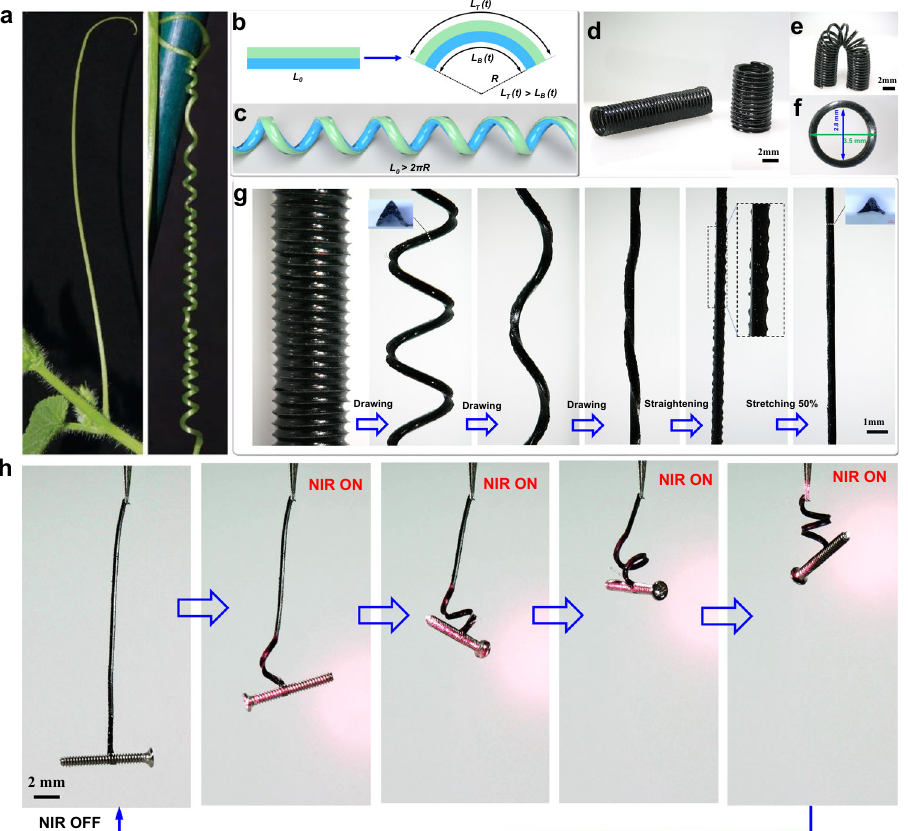
Fig. 1 Bioinspired design of self-winding fi ber actuator. a Photographs showing a straight tendril (left) and a coiled tendril (right). b , c A simpli fi ed physical model describing how the helical coiling of plant tendril is formed. In this model, the tendril is simpli fi ed as a fi lament composed of two layers. Differential growth in the two layers induces intrinsic curvature that leads to spontaneous formation of helices ( c ) to avoid steric interactions when the length of the fi lament is long enough ( L 0 > 2 π R ). L 0 is the initial length and R is the radius of the arc of the curved fi lament. L T ( t ) and L B ( t ) is the length of the top layer and the bottom layer of the curved fi lament after growing for a time t , respectively. d , e Photograph showing the precursor of helical soft springs used for the preparation of the self-winding fi ber actuators. f Photograph showing a coil of the helical soft spring from the top view. The outer and inner diameter of the coil is 3.5 mm and 2.8 mm, respectively. g Sequential photographs showing the shape changing of a stretched soft spring during the fabrication of a self-winding fi ber actuator. When the soft spring is stretched, it unwinds to turn a straight fi ber, it can be observed that one lateral side of straightened fi ber is smooth, while the other lateral side has wrinkles owing to their difference in length. Following 50% stretching smooths the wrinkled side and keeping the stretching at room temperature for 24 h, then the self-winding fi ber actuator (SWFA) is obtained. h Snapshots showing the shape change of SWFA from a straight structure to a helically coiled structure upon NIR irradiation (Supplementary Movie 1). The weight of the hanging object is 35 mg. The intensity of NIR light is ~4 W cm − 2